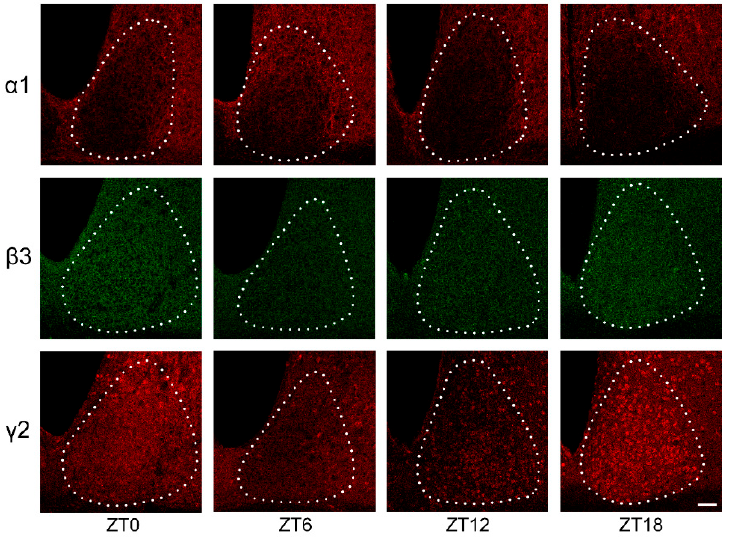
Figure 2. Representative photomicrographs of GABA A R α 1, β 3, and γ 2 subunit immunoreactivity in the SCN across four different time points in LD 12:12. Scale bar = 50 µm. Intensity of staining is indicated by strength of red ( α 1, and γ 2) and green ( β 3) signal. Margins of the SCN are indicated by dashed white line.